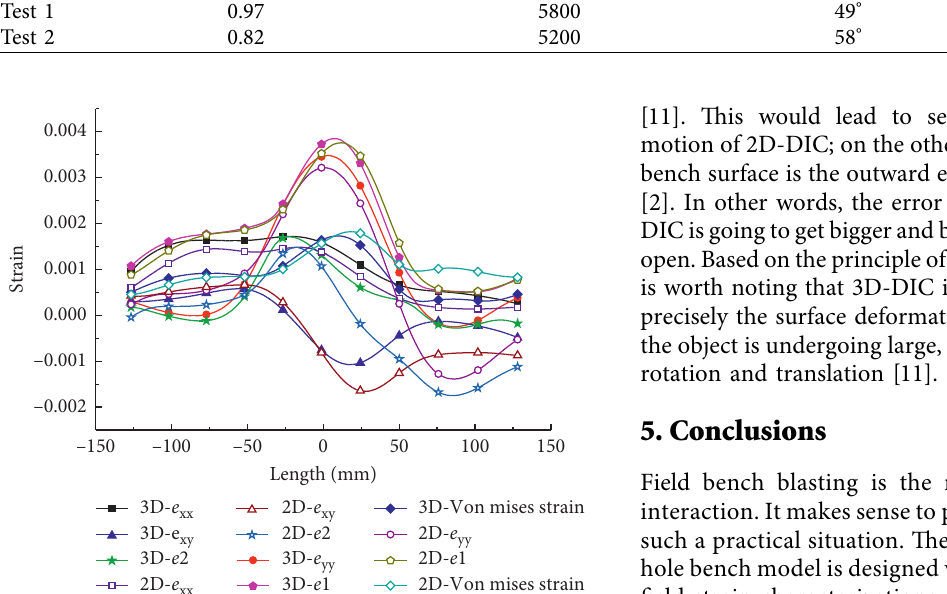
Figure 11: Comparison of 3D-DIC and 2D-DIC analysis at 200 µ s for test 2.